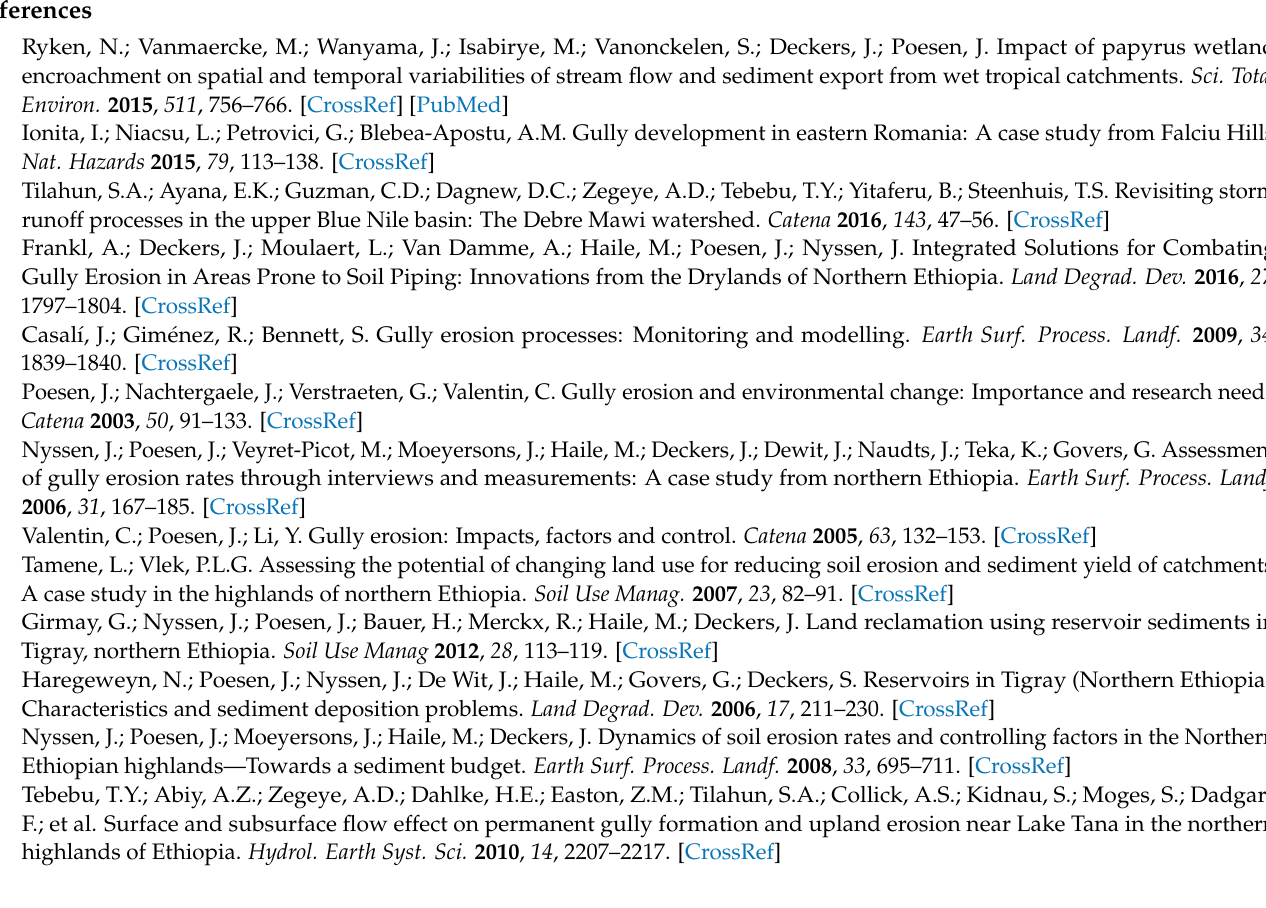
map, Figure S4: Profile curvature map, Figure S5: Soil texture map, Figure S6: Aspect map, Figure S7: Convergence index map, Figure S8: Drainage density map, Figure S9: Groundwater table map, Figure S10: Elevation map, Figure S11: Slope length map, Figure S12: Stream power index map, Figure S13: Topography position index map, Figure S14: Topographic wetness index map, Figure S15: Soil type